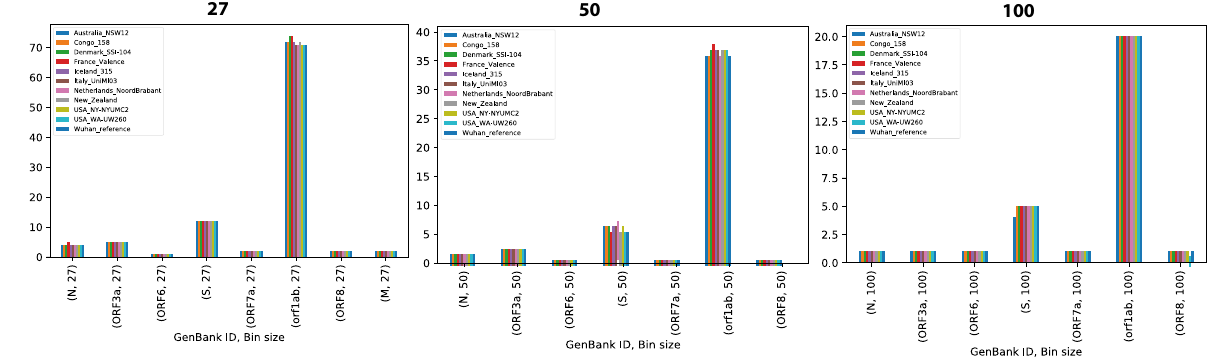
Figure 5. Application of the Antigen presentation (AP) based Monte Carlo epitope hotspot prediction method to mutated viral sequences from 10 different geographical locations, as well as the Wuhan reference sequence. Each group of bars shows the count of epitope hotspots found in the re- spective viral protein in each location. The epitope hotspot counts are shown for three different bin lengths: 27 (left), 50 (centre) and 100 (right). It is clear that the epitope hotspots are robust across mutation sequences. Only those hotposts that were identified for AP in Fig. 3 are illustrated in the plot.